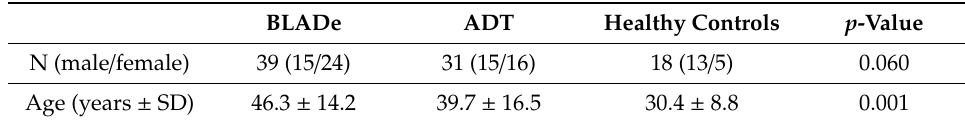
Table 1. Demographic overview. Di ff erences in sex distribution were calculated using the chi quadrat test. Di ff erences regarding age were calculated using analysis of variance (ANOVA). SD, standard deviation. ADT, MDD patients recruited for the study “AntiDepressive Therapy”; BLADe, MDD patients participating in the study “Blood Lipid Alterations in Depression”.